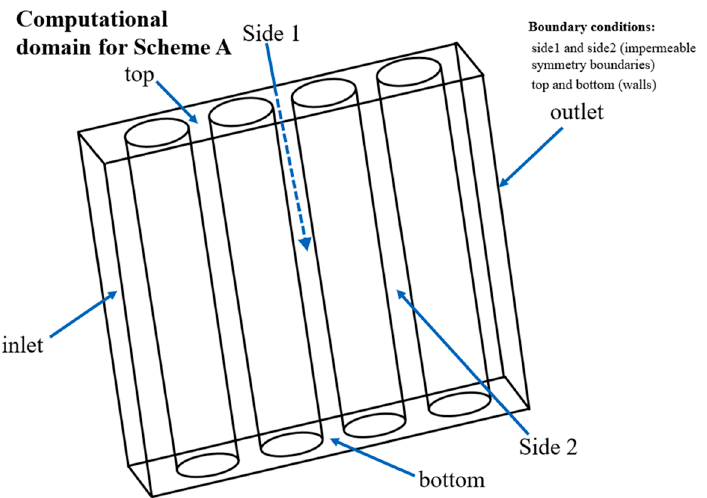
Figure 4. Computational domain for scheme A.